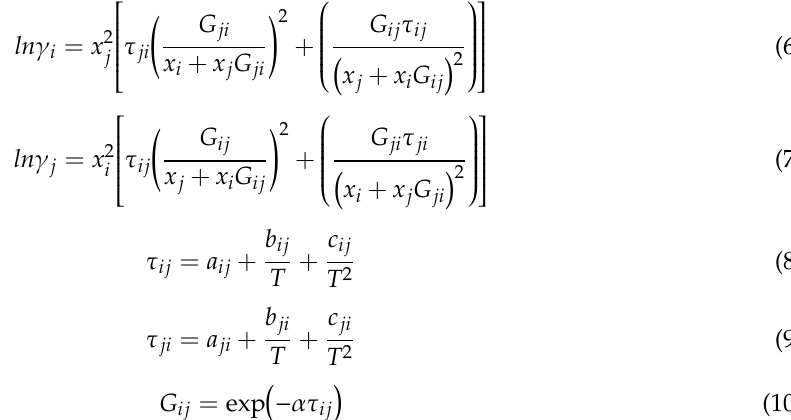
Figure 4. Catalysts 2020 , 10 , x FOR PEER REVIEW